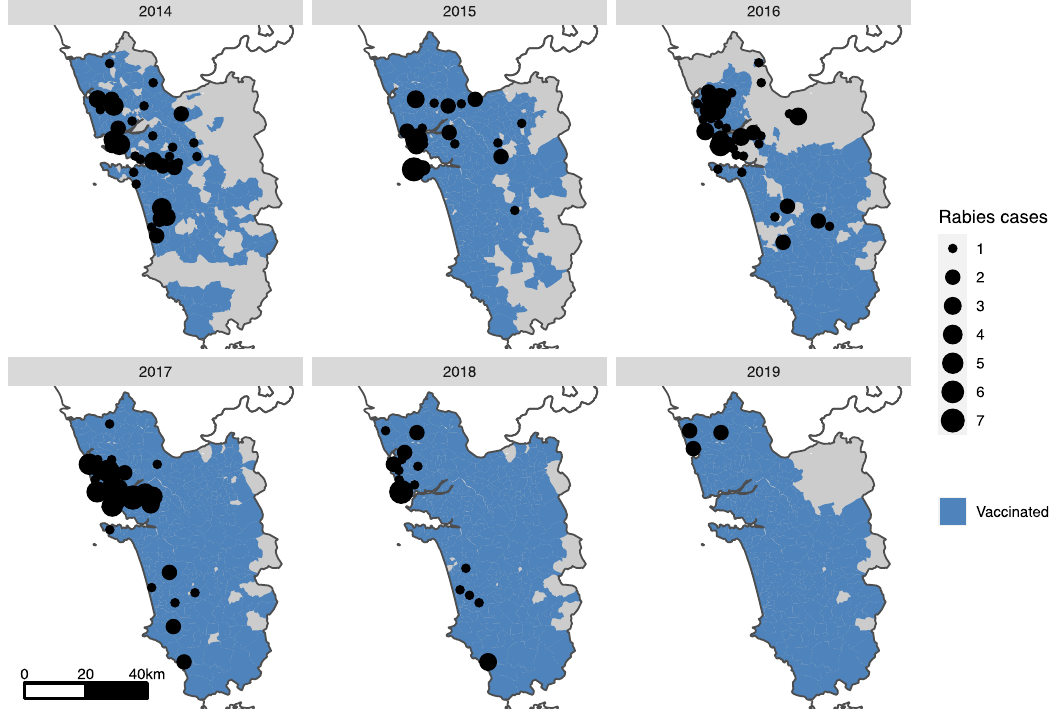
Fig. 2 Year-wise maps of Goa state showing canine rabies cases and the extent of dog vaccination. Maps of Goa state (gray shading) showing the villages/municipalities in which vaccination took place each year (blue shading) and positive canine rabies cases by village (black circles). A small-scale pilot dog vaccination campaign was conducted in 2013 (Supplementary Fig. 3), however, no location-speci fi c canine rabies surveillance data were available at this